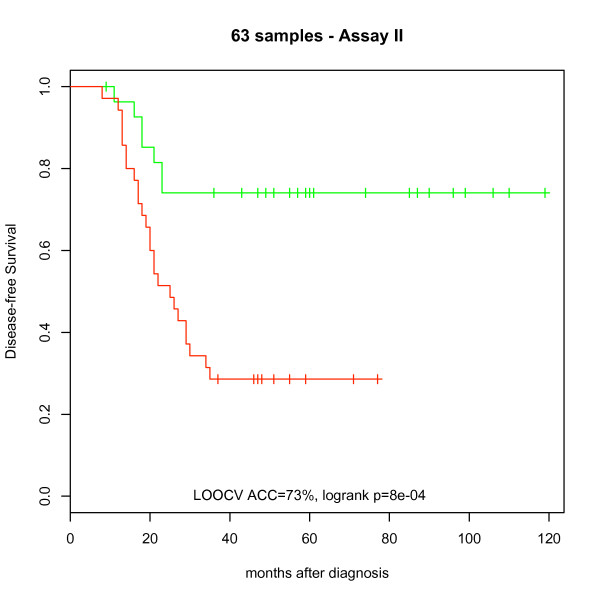
Kaplan-Meier plots of disease-free survival predictions (n = 63) in a leave-one-out cross-validation analysis (using the SVM-based classifier). Cases predicted to have recurrence are plotted separately (red) from those predicted to be recurrence-free (green).